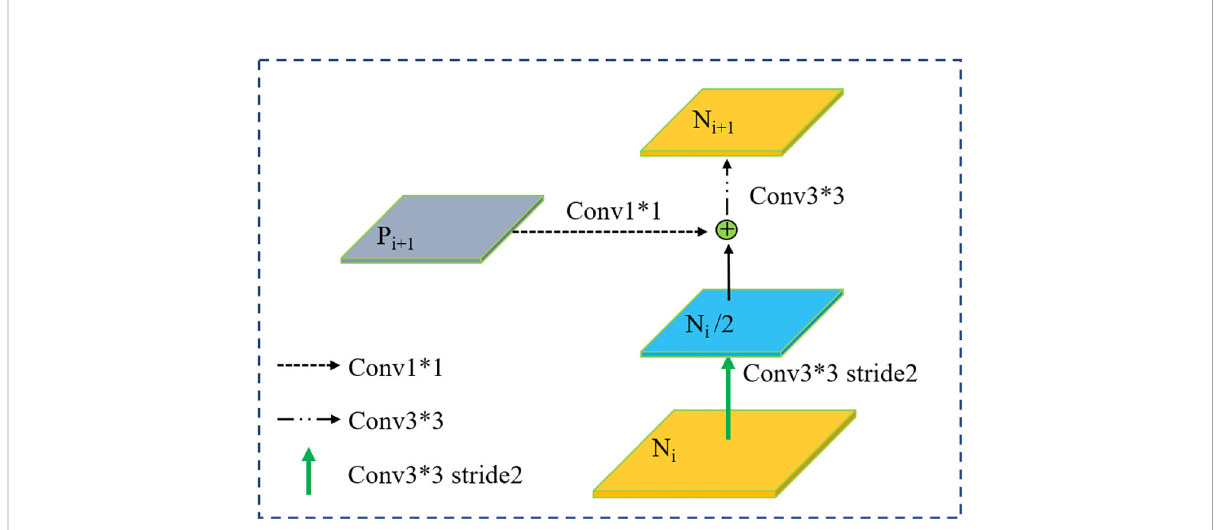
FIGURE 6 Bottom-up path augmentation. * indicates that the height and width of the convolution kernel matrix are